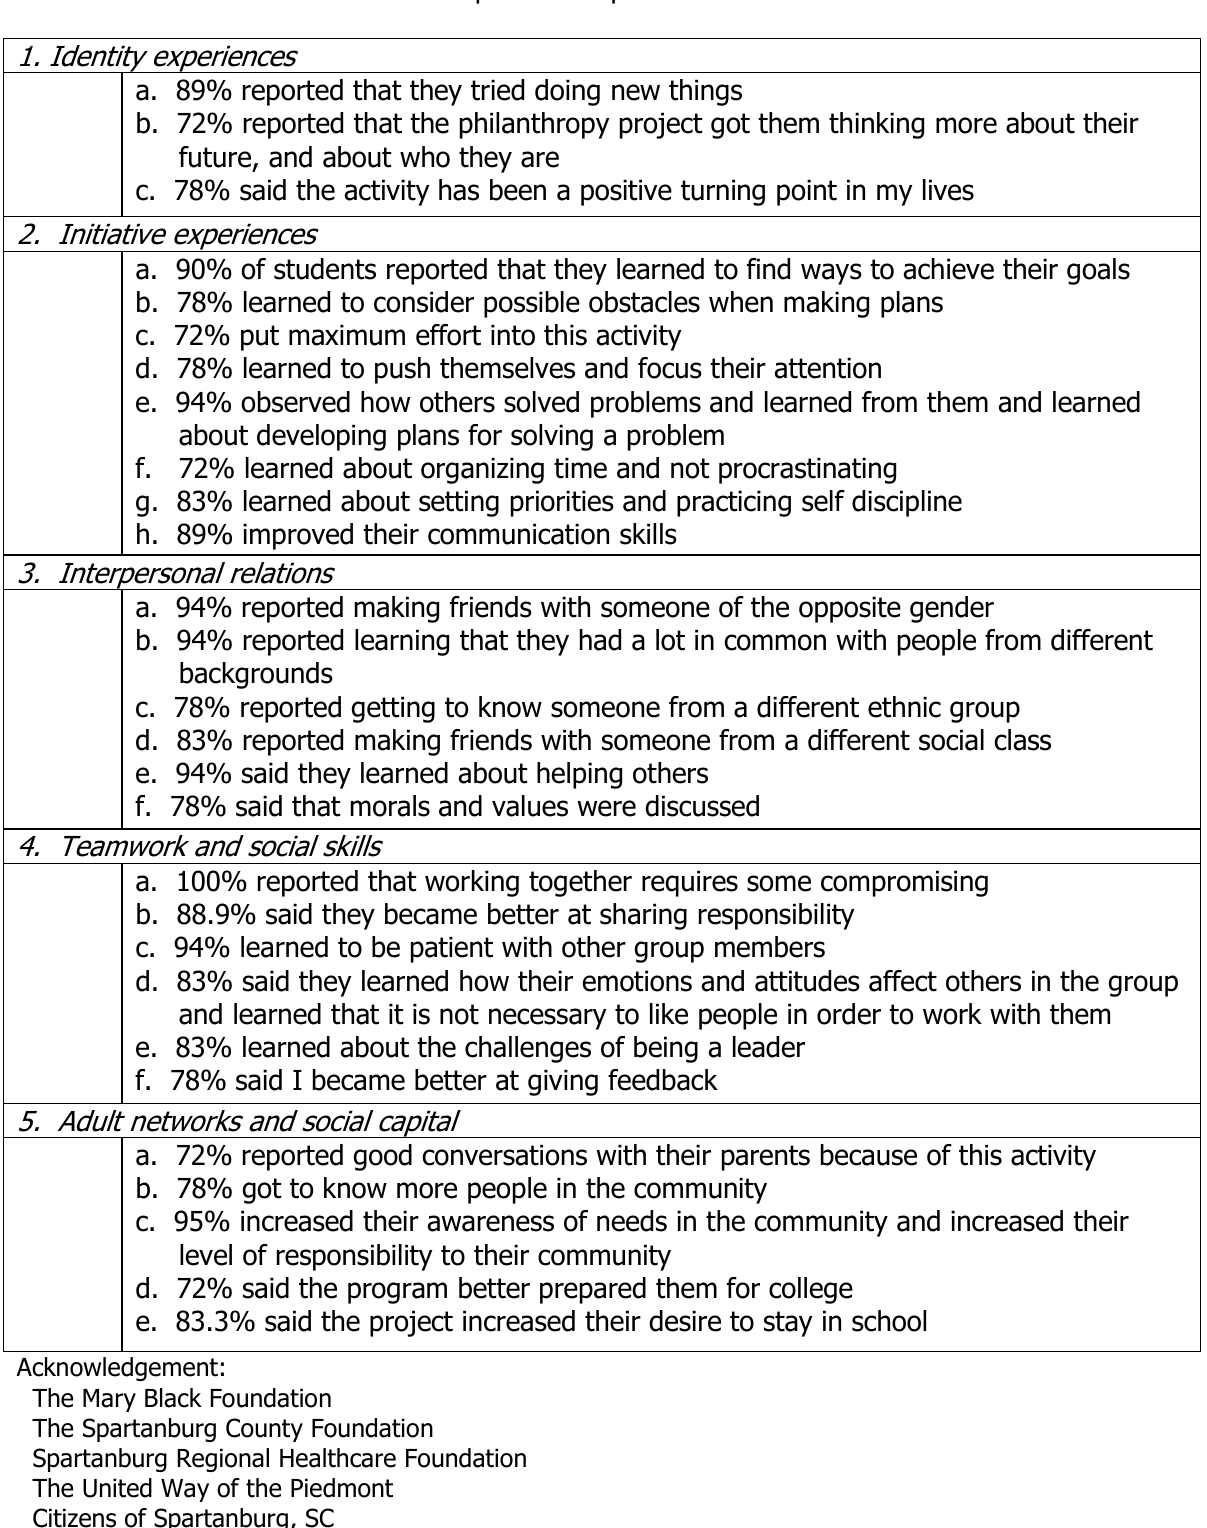
Youth Experience Survey 2.0